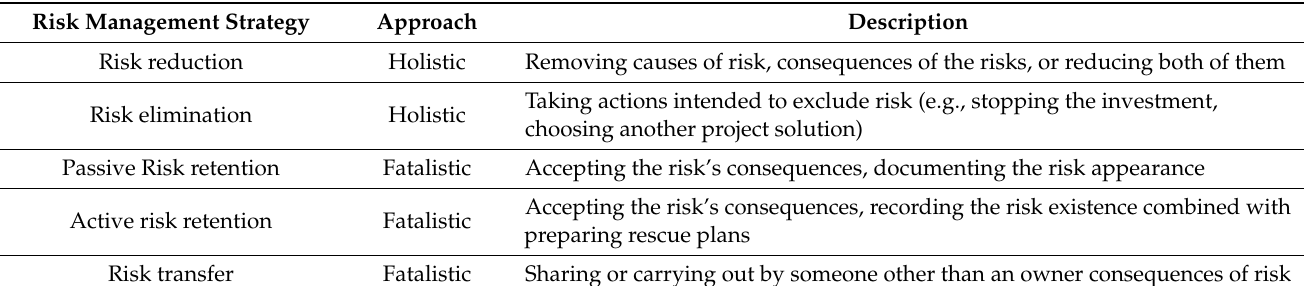
Table 4. The characteristics of various risk treatment strategies.